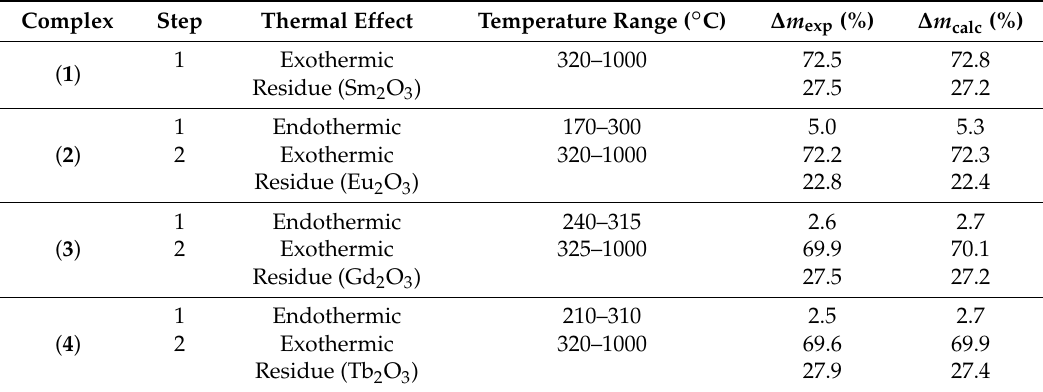
Table 1. Thermal decomposition data (in air flow) for complexes ( 1 )–( 4